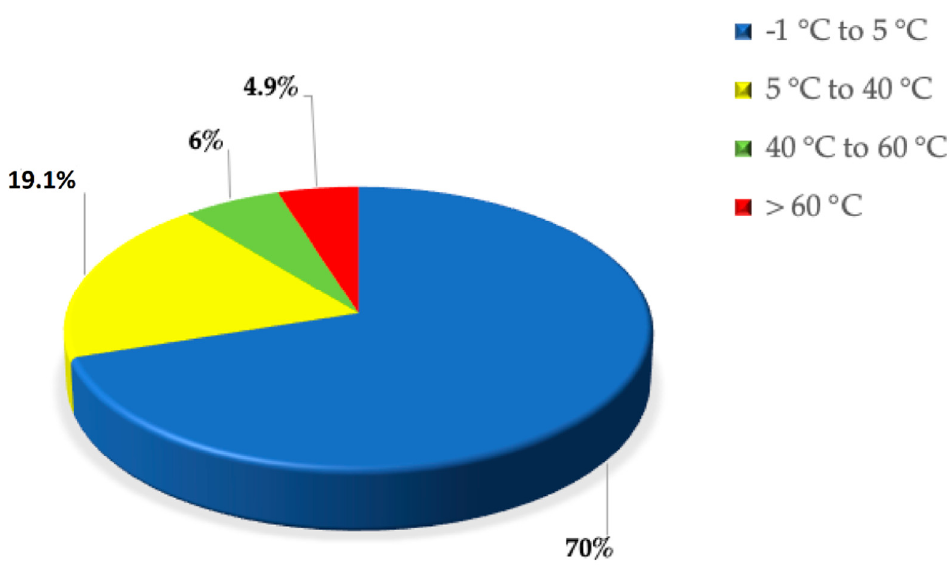
Figure 1. Pie–plot of Earth temperature distribution.